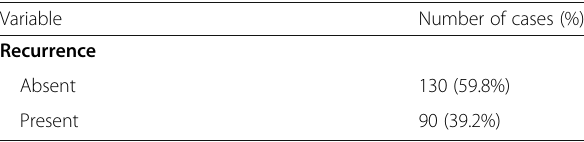
Table 1 Clinicopathological characteristics of the patients Variable